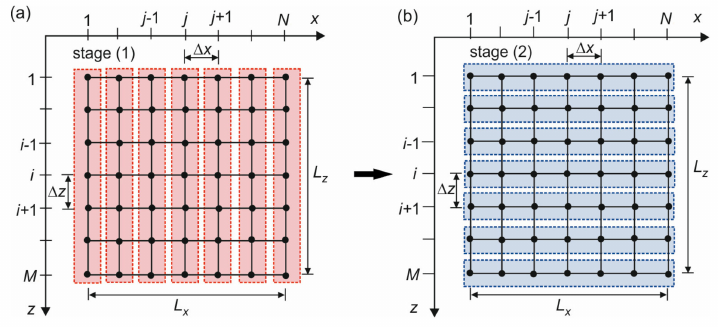
Figure 1. Computational spatial grid and sketch of dimensional splitting: ( a ) stage (1) in direction z , ( b ) stage (2) in direction